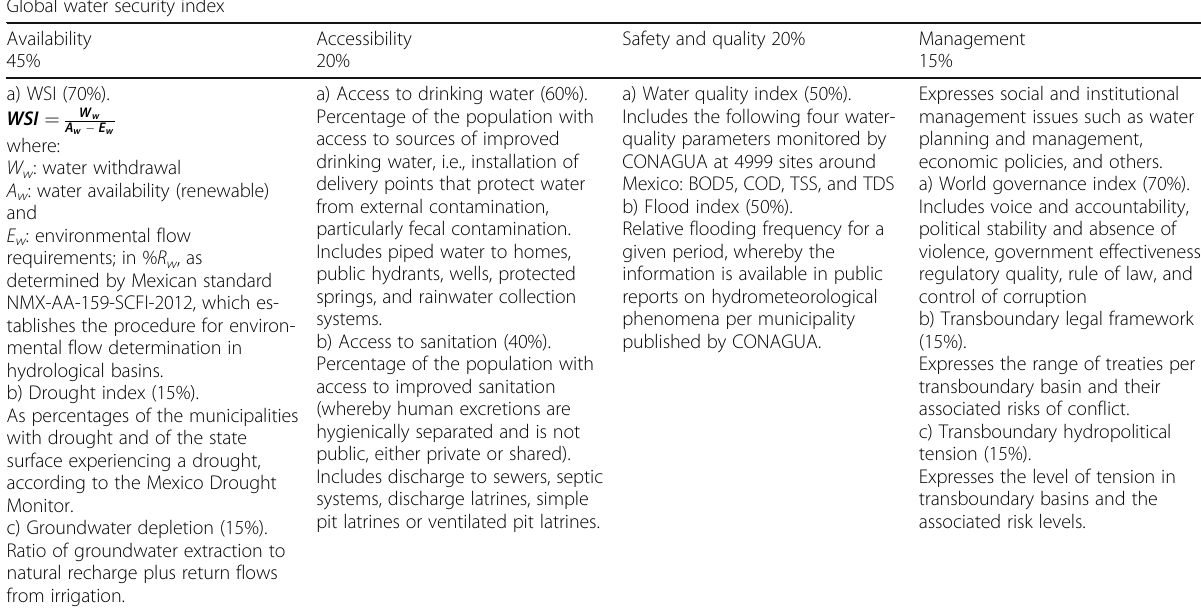
Table 4 Hierarchy and weights for obtaining the state-level global water security index in our study Global water security index